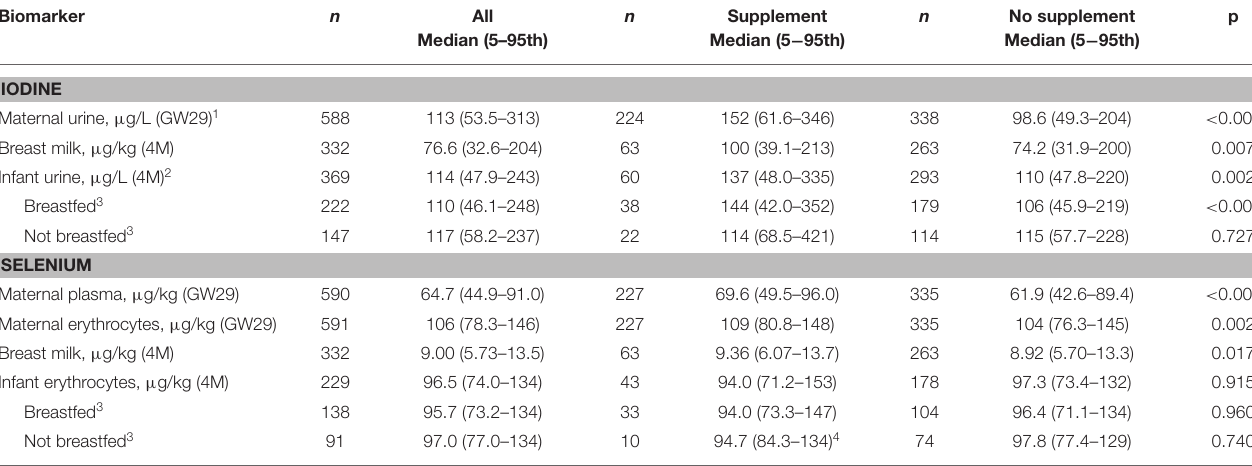
TABLE 3 | Biomarker iodine and selenium concentrations in gestational week 29 (GW29), gestational week 34 (GW34), and at 4 months postpartum (4M) for all included mothers and infants and grouped by use of multivitamin supplement with minerals.